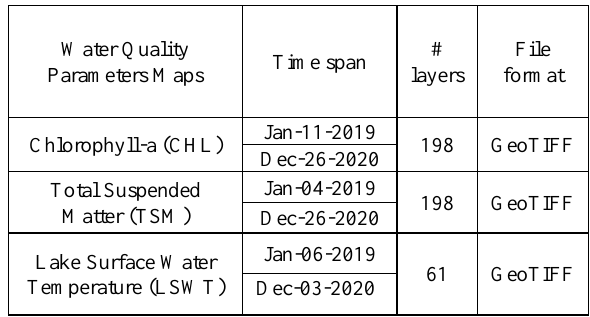
Table 1-3 summarize the currently available datasets in the platform.